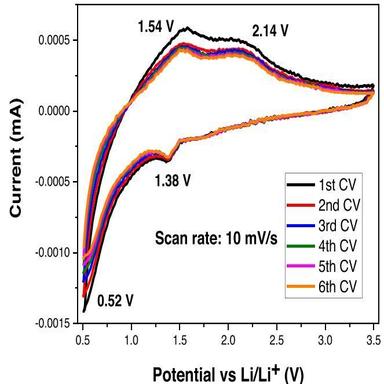
Cyclic voltammograms of Fe-BDC-DMF at potential window of 0.5-3.5 V, T = 20°C, 1M LiPF6 dissolved in EC-DMC (1:1 vol) as electrolyte, Celgard as a separator.